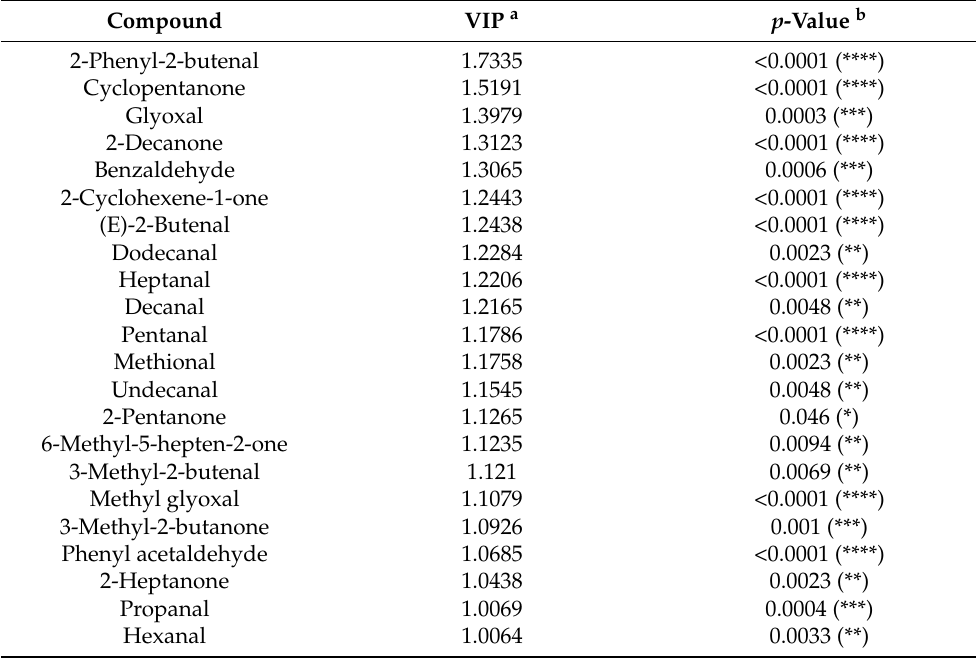
Figure 6. OPLS-DA of different regions of rice Huangjiu, ( a ) semidry Huangjiu, and ( b ) semisweet Huangjiu . Table 6. OPLS-DA results showing the critical volatile carbonyl compounds (variable importance in projection VIP > 1.0, p < 0.05) present across semidry Huangjiu samples of different regions (Zhejiang, Jiangsu, Shanghai, Fujian).